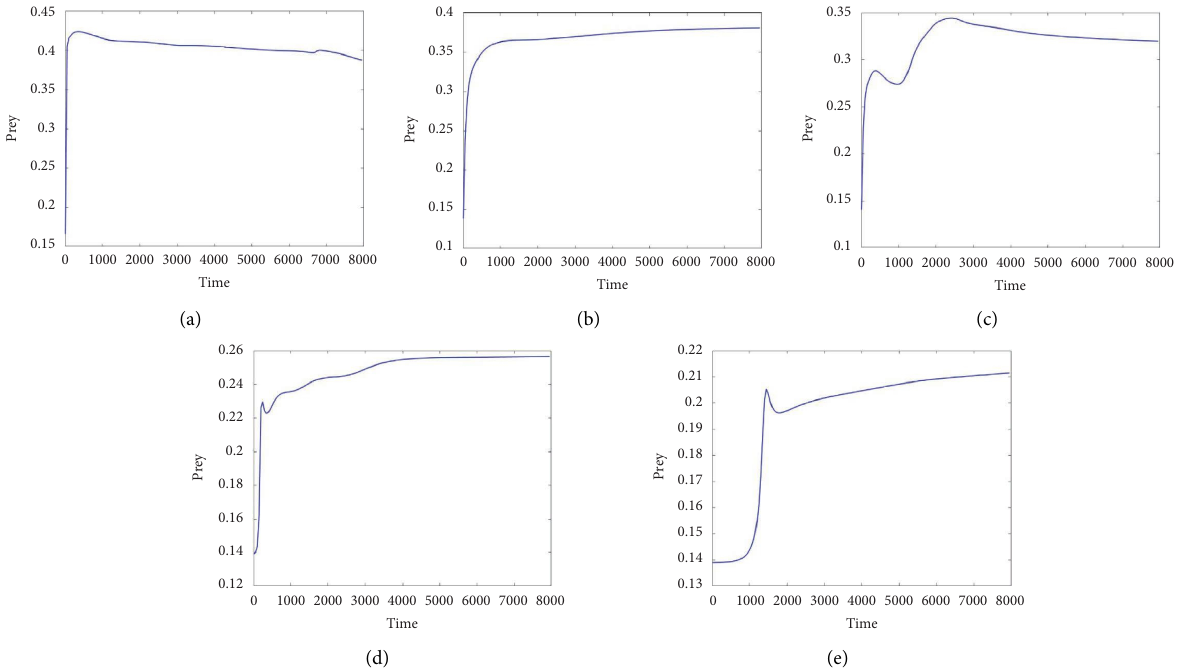
Figure 5: Time-series of prey’s density at spatial location ( 21 , 21 ) . (a) q � 0, (b) q � 0 . 4, (c) q � 0 . 6, (d) q � 0 . 8, and (e) q � 1.